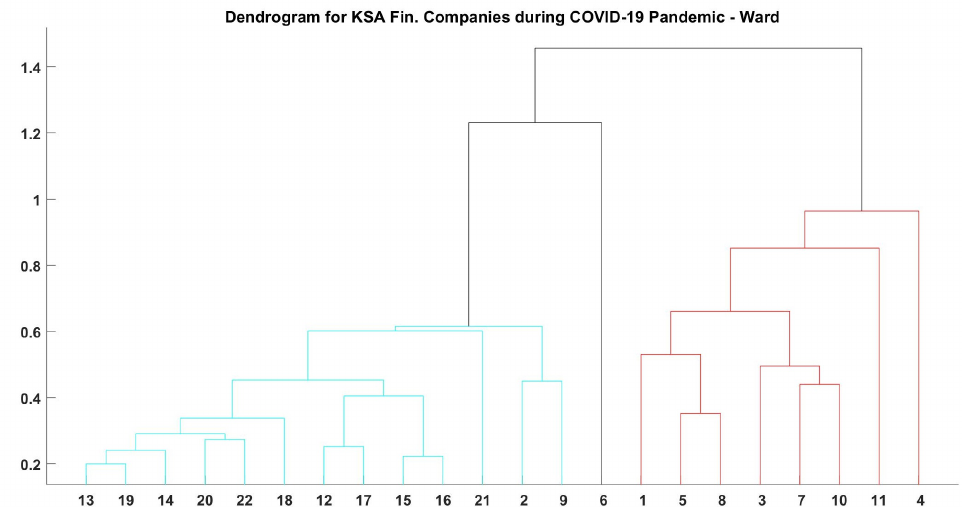
Figure 6. Ante COVID-19 pandemic hierarchical cluster tree on the performances of insurances (first 11 time series) and banks (from 11 to 22). Distance metric = Euclidean, linkage = Ward, mean of inconsistency coefficient (excluding zeros) = 0.8554. There is no clear distinction between banks and insurers.